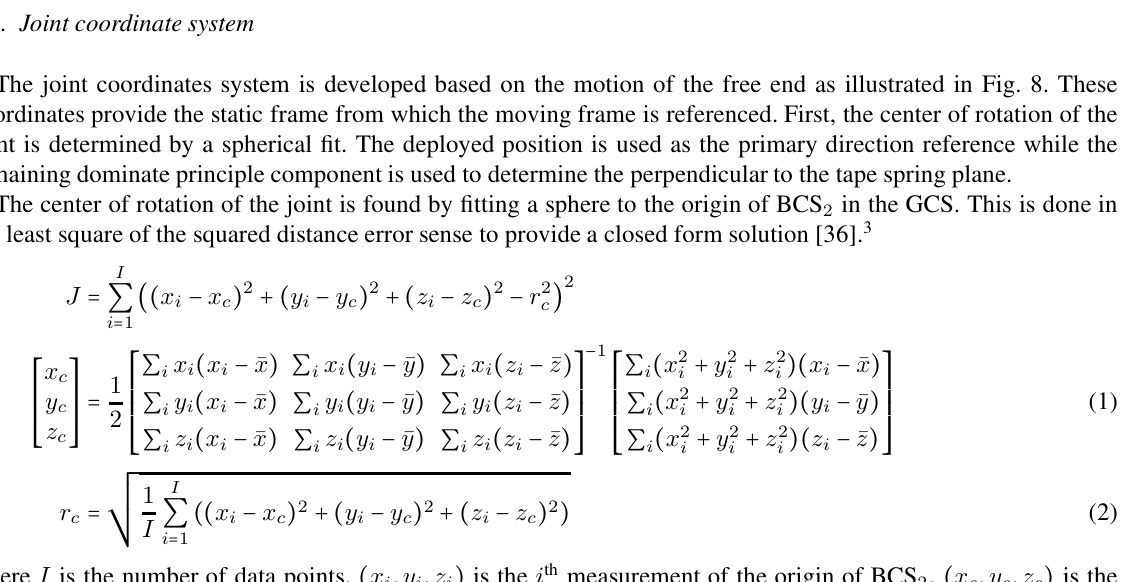
Fig. 8. Joint coordinates are developed by the position of the deployed end. Data comes from a set of near perpendicular